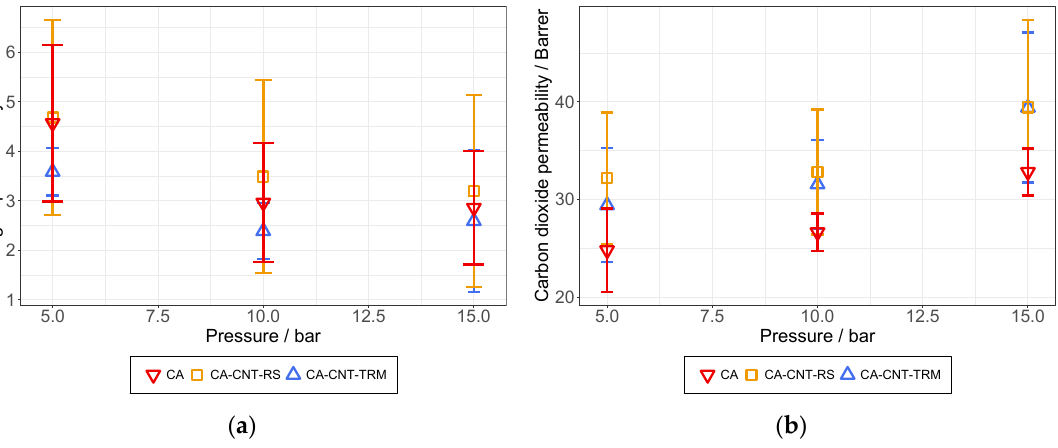
Figure 14. Gas permeation at feed pressures of 5, 10, and 15 bar measured with N 2 ( a ) and CO 2 ( b ).